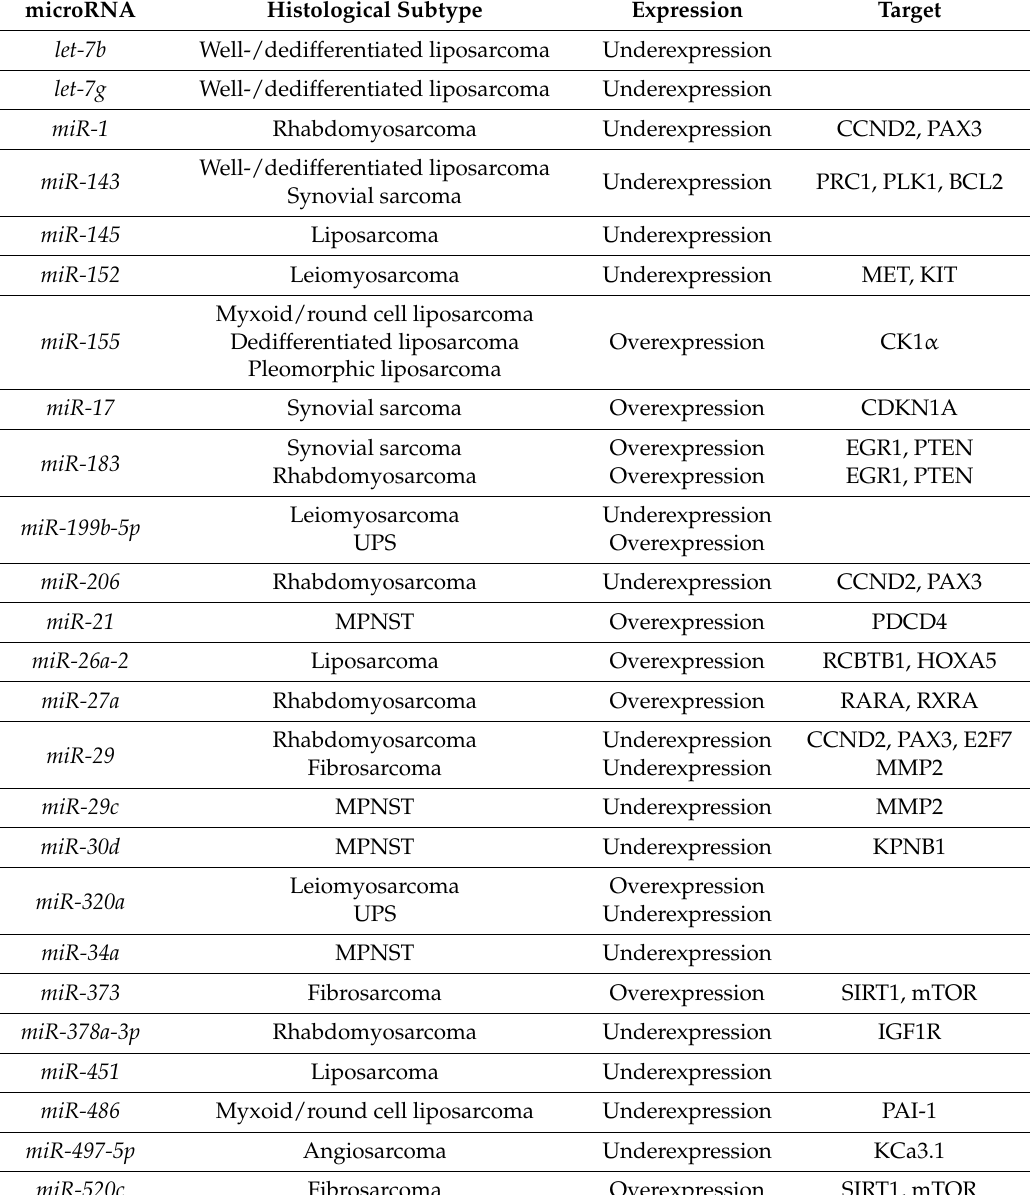
Table 1. Expression pattern of miRNAs in different STS-subtypes and their target